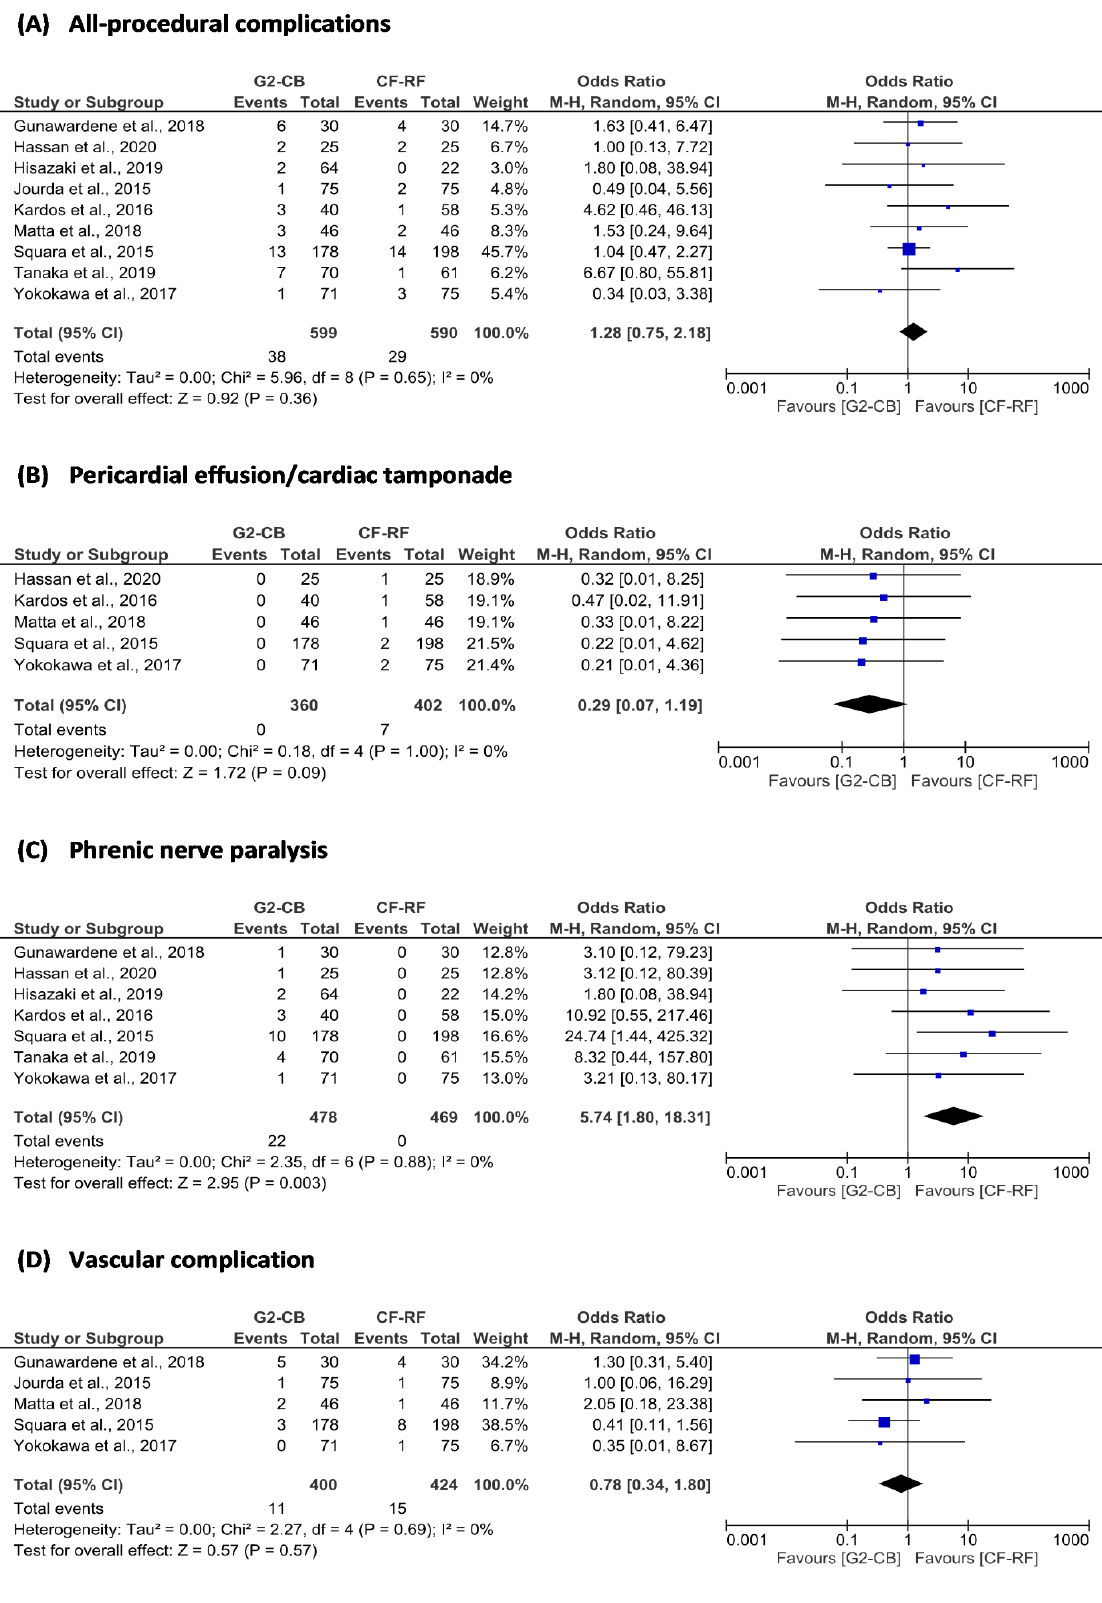
Figure 4. Forest plot of ( A ) all-procedural complications; ( B ) pericardial effusion/cardiac tamponade; ( C ) phrenic nerve paralysis; and ( D ) vascular complications. 2G-CB = second-generation cryoballoon ablation; CF-RF = contact force-sensing radiofrequency ablation; CI = confidence interval; M – H = Mantel – Haenszel.